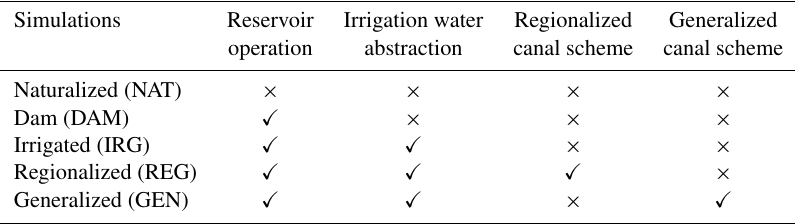
Table 3. The different simulations carried out in this